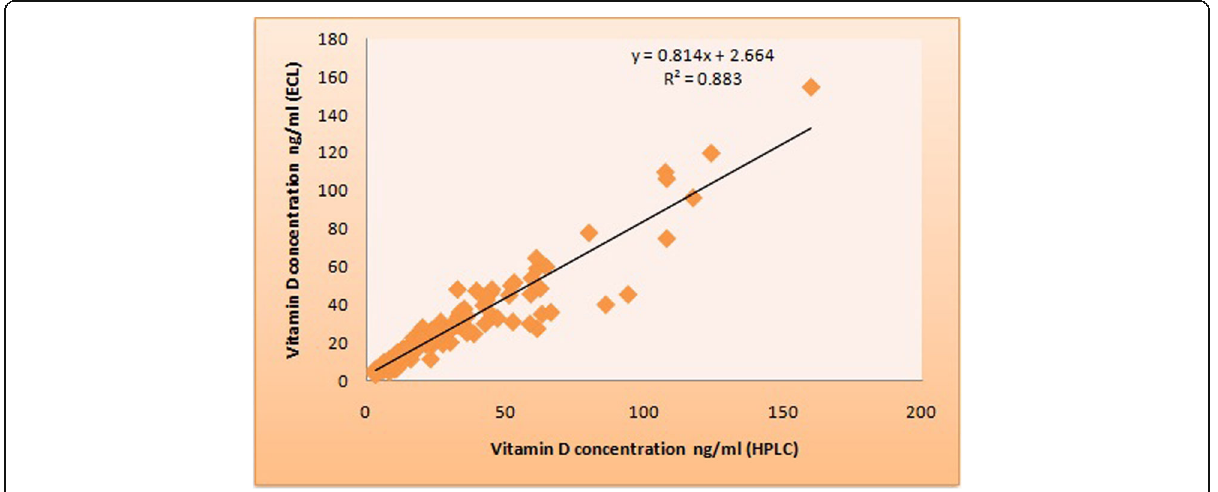
Fig. 3 Evaluation of 25-OH vitamin D in human serum samples with HPLC and